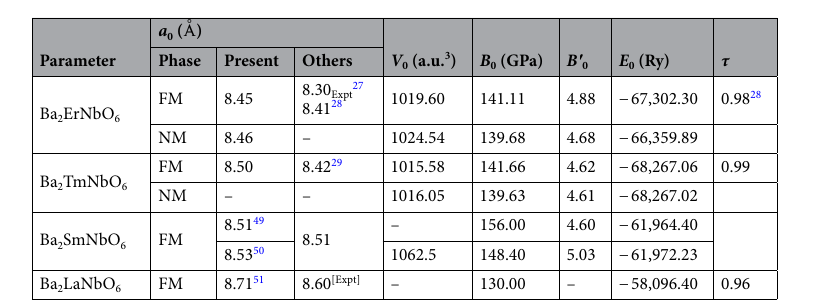
Table 1. Retrieved physical characteristics of Ba 2 ErNbO 6 and Ba 2 TmNbO 6 in ferromagnetic (FM) and non- magnetic (NM) configurations.